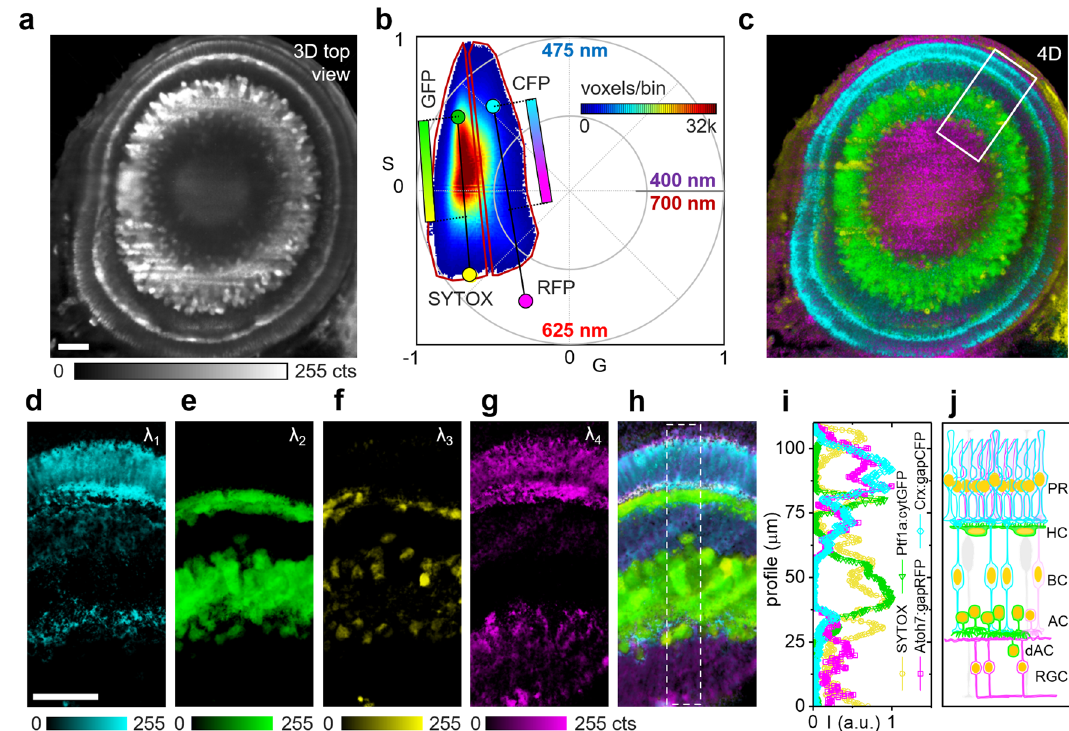
Fig. 3 Retinal hyperspectral images of a transgenic SoFa 72 hpf zebra fi sh. a Sliced maximum intensity projection (MIP) of 3D fl uorescence image data showing the eye of a fi xed 72 hpf SoFa zebra fi sh expressing Crx:gapCFP, Ptf1a:cytGFP, Atoh7:gapRFP plus SYTOX Orange nuclear stain. b Phasor plot of the total 151 z sections acquired by fl uorescence collection though sine/cosine fi lters, color-coded circles indicate the theoretical locations of the pure fl uorophore emissions. The phasor histogram was divided into two halves, the voxels in each half were color coded according to their position along the connecting lines of the two fl uorophore pairs (CFP/RFP, GFP/SYTOX) with the indicated color maps (cyan/magenta, green/yellow). c MIP of 4D image data of the view shown in a color coded according to the voxel positions in b to indicate the dominant component. d – h Zoomed-in MIPs of 20 slice 3D fl uorescence volume renders of the region indicated in c spectrally separated according to the voxel positions in b . i Normalized intensity pro fi les within the region marked in h indicative of the retinal cellular composition. j Cartoon of the underlying cell composition (PR photoreceptors, HC horizontal cells, BC bipolar cells, AC amacrine cells, dAC displaced amacrine cells, RGC retinal ganglion cells). All zebra fi sh labels were excited simultaneously via two photon absorption at 920 nm. Representative fi sh from three imaging sessions on three different days. Scale bars, 25 µ